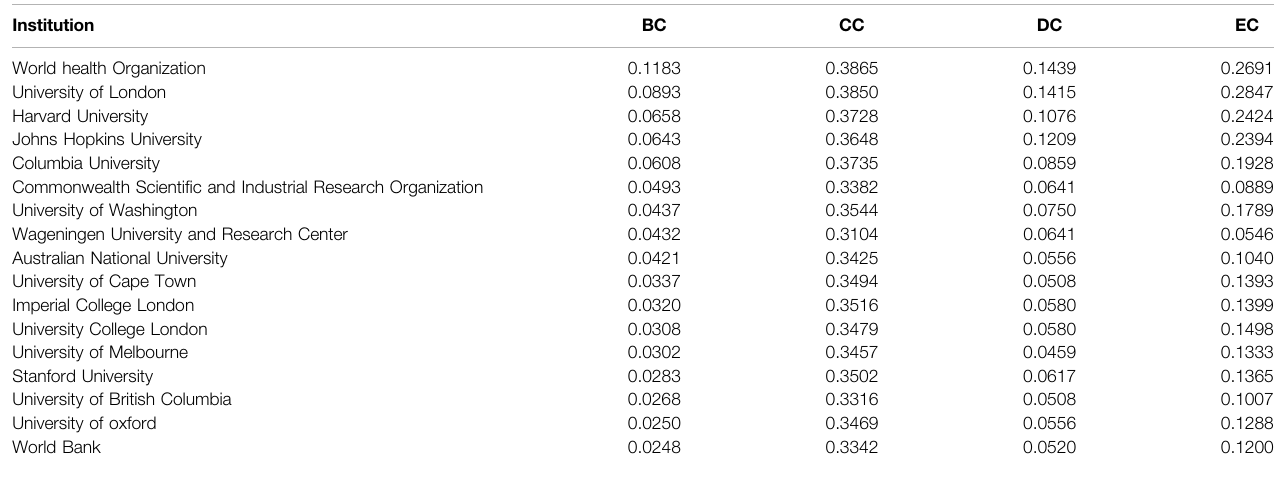
TABLE 5 | Centrality measures for institutions that consistently ranked highest and with two or more co-authored publications. Institution